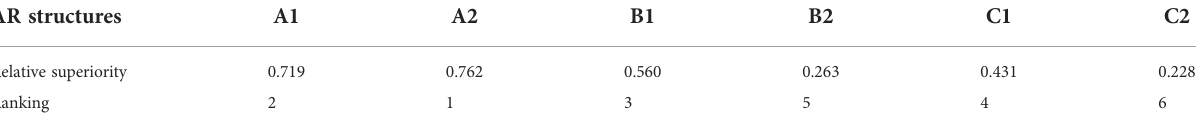
TABLE 5 Superiority ranking of the fl ow- fi eld effect of ARs with six basic structures. AR